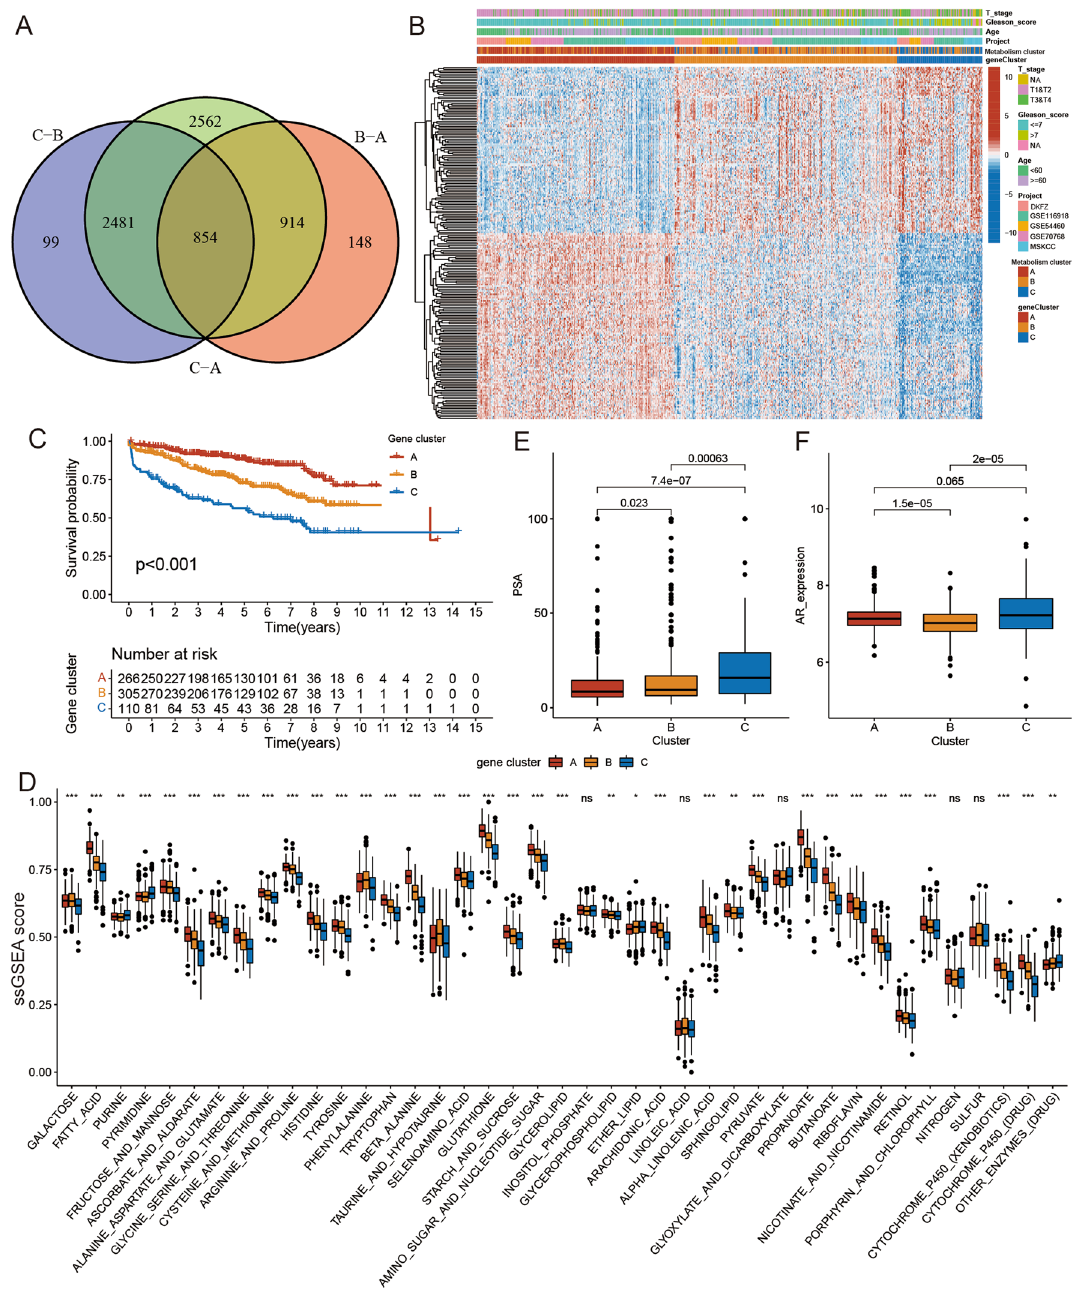
Figure 2. Identification of metabolic gene subtypes. ( A ) Venn diagram depicting 854 differentially expressed genes in three metabolism clusters. ( B ) Unsupervised clustering of DEGs among three metabolism clusters to classify patients into three groups: gene cluster A–C . ( C ) Kaplan–Meier curves for the three groups of patients. The log-rank test showed an overall p < 0.001. ( D ) The metabolic ssGSEA scores in three gene clusters. The difference in PSA ( E ) and AR expression ( F ) among distinct gene clusters. The statistical difference of three gene clusters was compared through the Kruskal–Wallis test. * p < 0.05; ** p < 0.01; *** p <